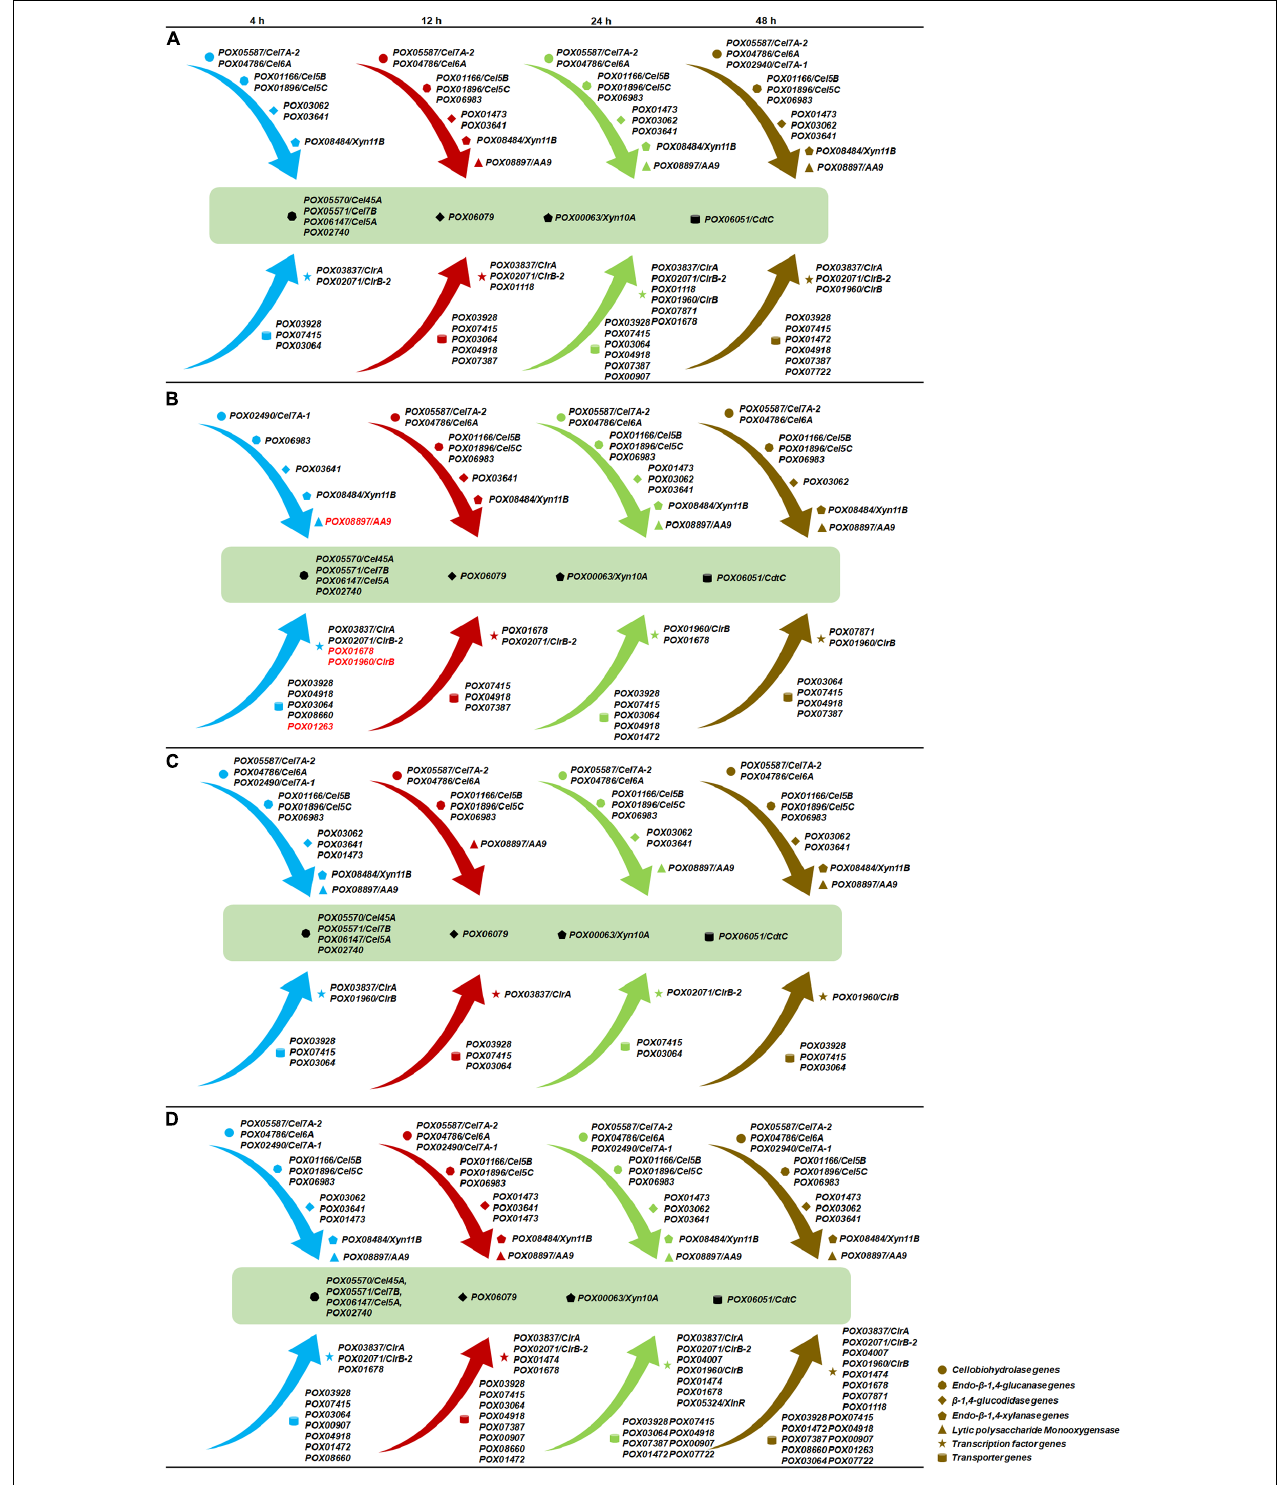
FIGURE 14 | Model of sequential gene expression in response to various carbon sources in P. oxalicum . (A) Avicel; (B) wheat bran; (C) 2-hydroxyethyl cellulose; (D) methyl cellulose. Gene IDs in black indicate up-regulated genes on the corresponding carbon sources compared with no carbon source, while gene IDs in red indicate down-regulated genes. Genes in dark green were co-activated by all four induced carbon sources over the whole culture time. Arrows in blue, red, green and brown represent different induction times, recoding as 4, 12, 24, and 48 h, respectively.